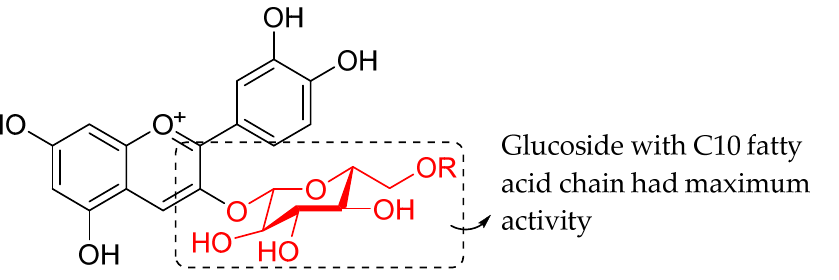
Table 22. Antibacterial activity of flavone derivatives against B. subtitlis , S. aureus , and P. aeru- ginosa .